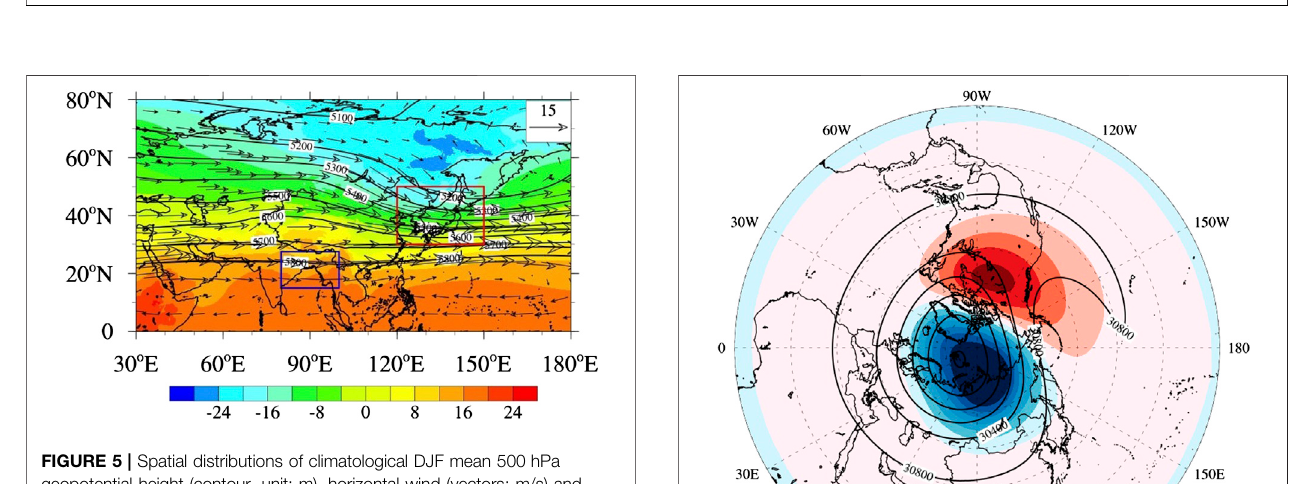
FIGURE4| MoistureprocessesresponsiblefortheDJFmeanprecipitationoverthemainrainfallarea(20 ° – 50 ° N;100 ° – 135 ° E)inChina. (A) Evaporationanomalies, horizontalmoisture advection and total moisture fl ux convergence contributed to the precipitation anomalies. (B) The contributions ofmoisture, circulation changesand nonlinear term to the moisture advection. (C) The contributions of moisture, circulation changes and nonlinear term to the moisture fl ux convergence. Unit: mm/day.